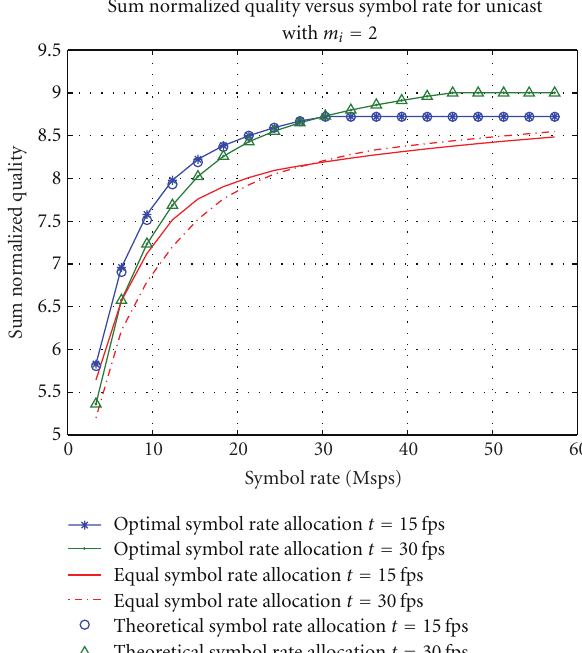
Figure 11: Unicast :sum normalized quality versus symbol rate at t = 15 and 30fps with m